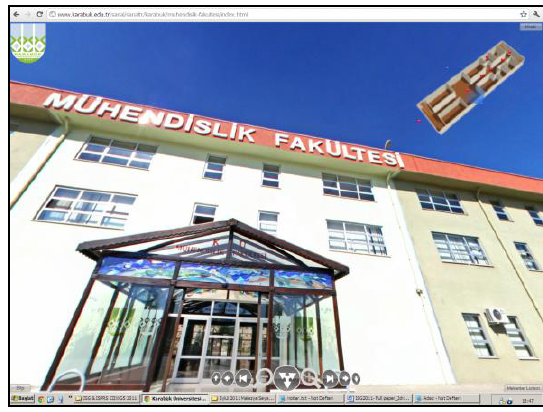
Figure 16. Panoramic View Library of Karabuk University